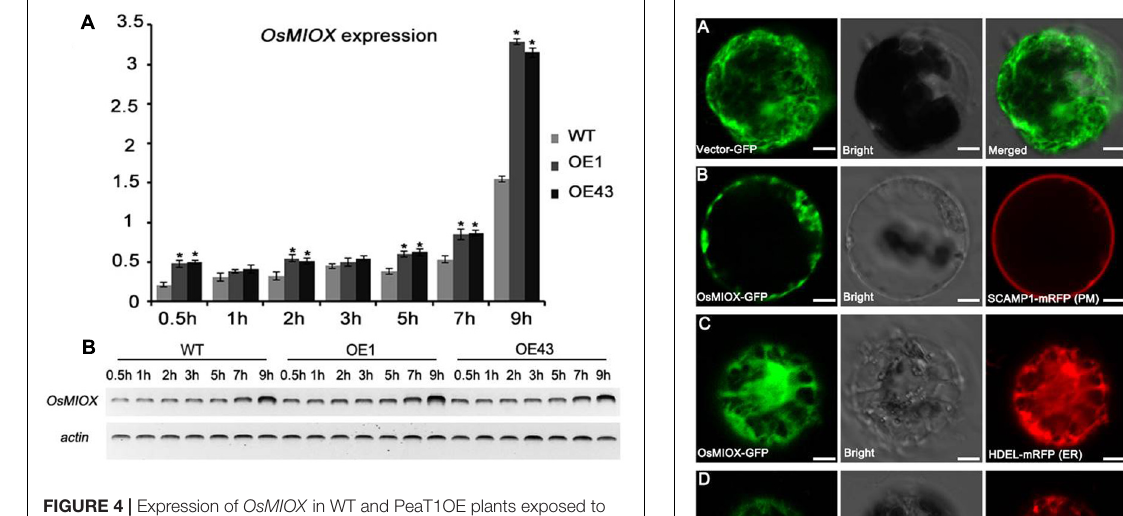
FIGURE 4 | Expression of OsMIOX in WT and PeaT1OE plants exposed to air. (A) qRT-PCR analysis of OsMIOX expression. (B) OsMIOX expression was detected by semi-quantitative RT-PCR. Data is presented as the mean ± standard deviation ( n = 9). Significant differences are determined with Student’s t -test ( ∗ 0.01 < P < 0.05, ∗∗ P < 0.01).